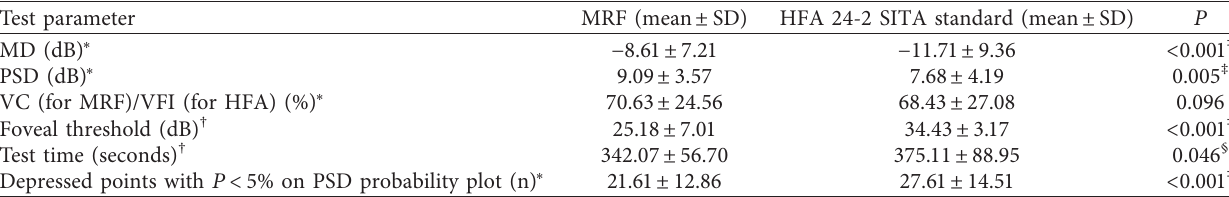
Figure 4: Visual field output for Melbourne Rapid Fields (MRF) full test. Table 1: Comparison of various test parameters for Melbourne Rapid Fields (MRF) and Humphrey Field Analyzer (HFA) 24-2 Swedish Interactive Threshold Algorithm (SITA) standard